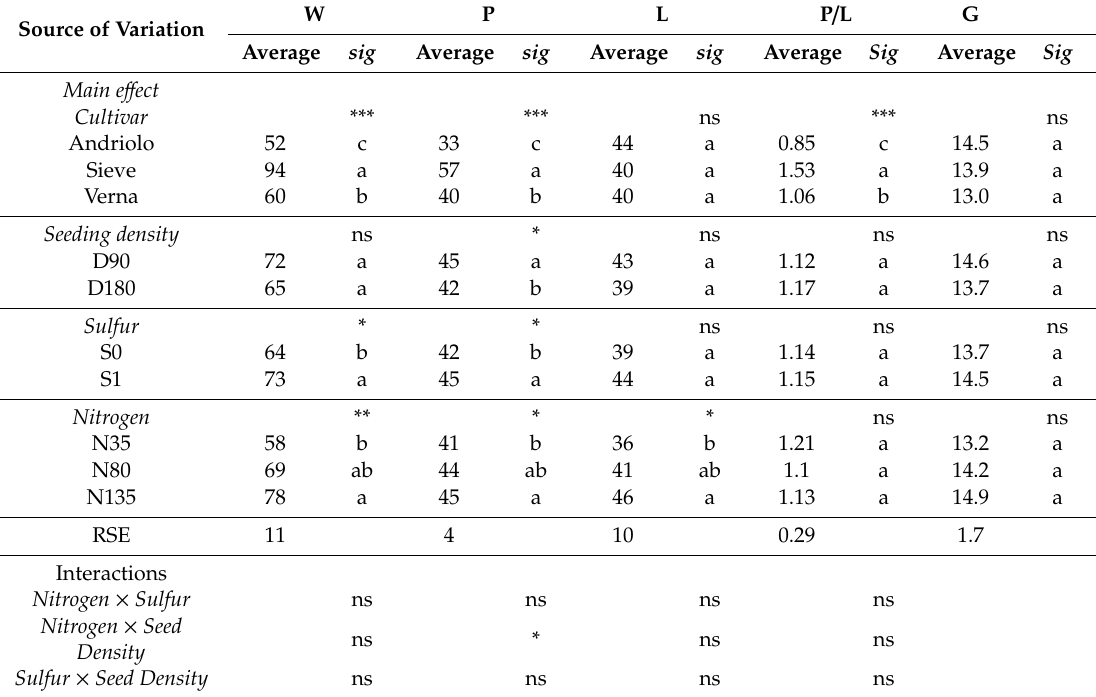
Table 3. Mean of alveograph results by nitrogen fertilization, sulfur fertilization, seed density, cultivar and first order interaction. The sig columns report the ANOVA results (* = 0.05, ** = 0.01, *** = 0.001, ns = not significant), while lowercase letters represent the Tukey HSD post hoc test results. RSE = residual standard